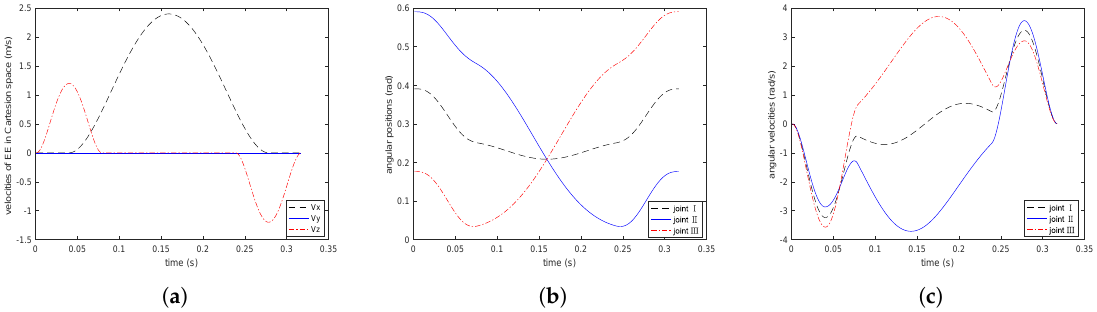
Figure 6. Simulation results of trajectory planning with the comparison method. ( a ) EE’s velocities in Cartesian space; ( b ) Angular positions; ( c ) Angular